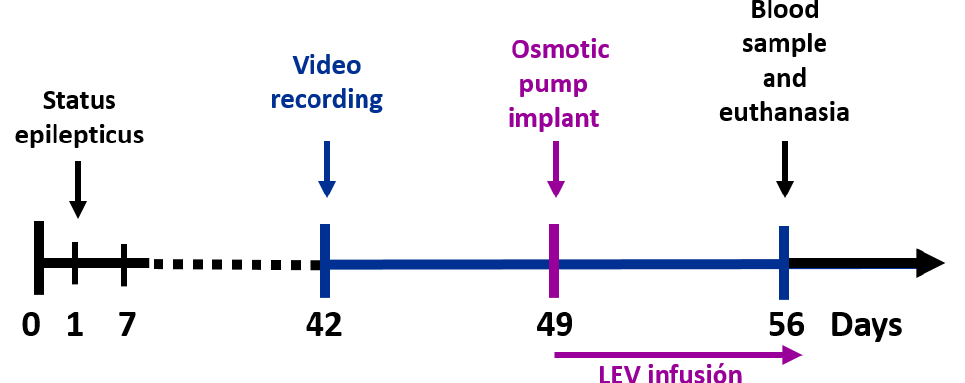
Figure 1. Experimental design. Status epilepticus (SE) was induced on day 1. Subsequently, spon- taneous recurrent seizures were recorded before (days 42 – 48) and during (days 49 – 56) LEV treat- ment. A blood sample and the brain were obtained after humane euthanasia. LEV,